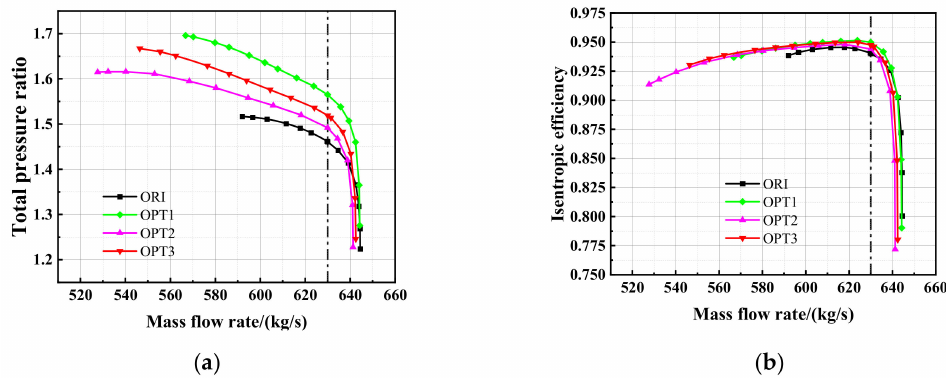
Figure 9. Compressor performance maps: ( a ) total pressure ratio characteristic line; ( b ) isentropic efficiency characteristic line.